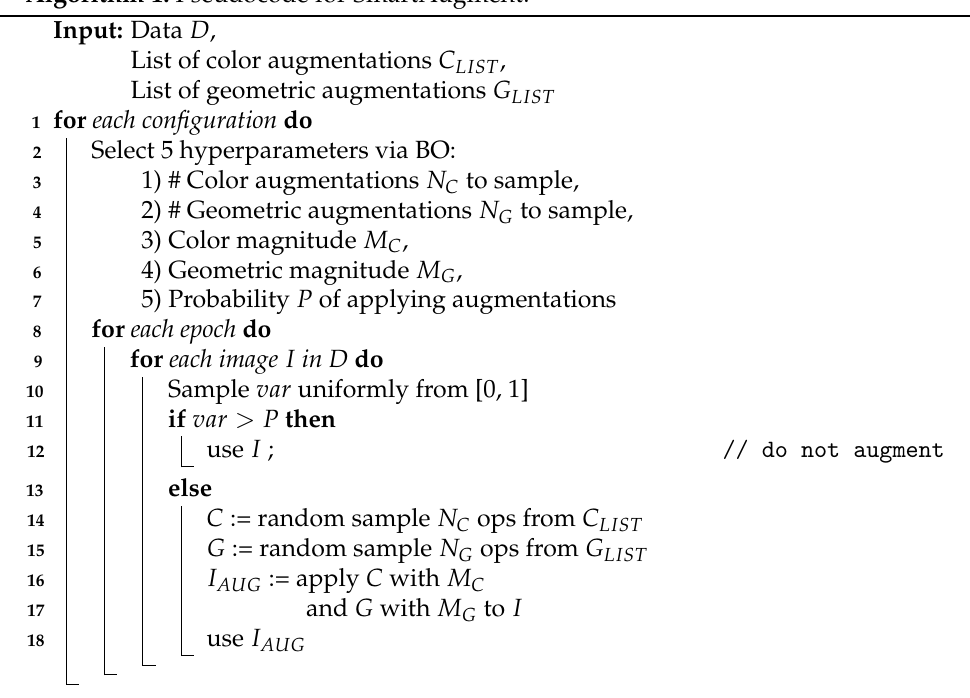
Algorithm 1: Pseudocode for SmartAugment.